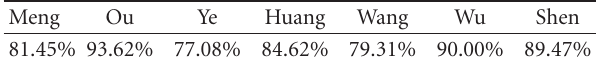
Table 3: Test results on driver identifications via SVM. Meng